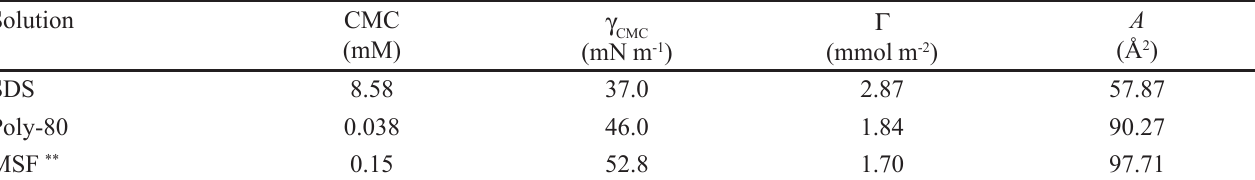
* CMC values: 8.3 mM for SDS (Gander et al., 1985; Patist et al , 2002) and 0.022 mM for Poly-80 (Decroos et al., 2007) ** expressed as molar concentration of matesaponin-1 (MW: